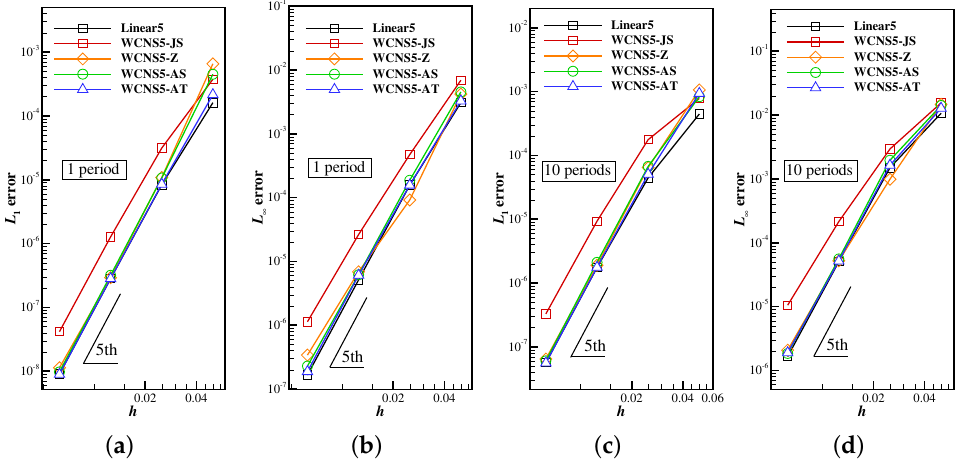
Figure 16. L 1 and L ∞ errors of density of isentropic vortex transport problem: ( a ) L 1 error, 1 period; ( b ) L ∞ error, 1 period; ( c ) L 1 error, 10 periods; ( d ) L ∞ error, 10